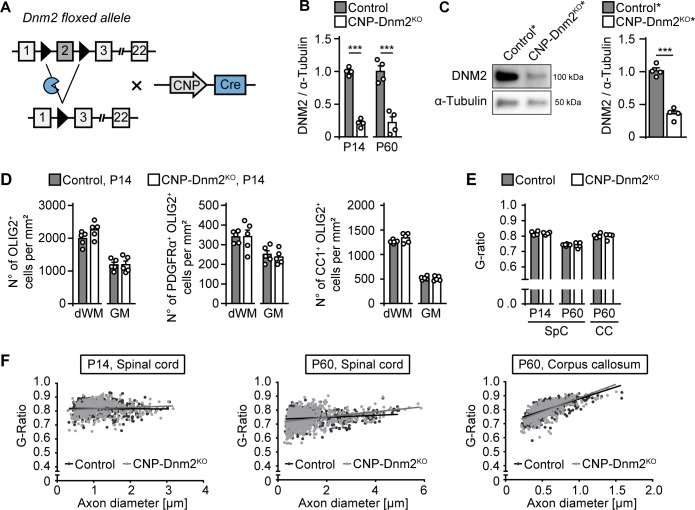
Dynamin 2-depleted oligodendrocytes do not show detectable defects in differentiation and myelination.(A) Schematic representation of Dnm2 ablation in the OL lineage. Exon 2 of Dnm2 is flanked by LoxP sites and excised upon expression of Cre recombinase under the control of CNPase gene regulatory elements. (B) Quantification referring to Figure 5A, full-length blot Supplementary file 1C. Relative amount of DNM2 in spinal cord extracts from Dnm2loxP/loxP (control) and CnpCre:Dnm2loxP/loxP (CNP-Dnm2KO) mice (P14, P60). Control average was set to 1. N = 4 mice/genotype, two-tailed unpaired Student’s t-test. (C) (left panel) Exemplary immunoblot of DNM2 in extracts of primary mouse OLs derived from CnpCre:Rosa26-stoploxP/loxP-YFP (control*) and CnpCre:Dnm2loxP/loxP:Rosa26-stoploxP/loxP-YFP (CNP-Dnm2KO*) from P7 brain (after 14 day in culture). (right panel) Relative amounts of DNM2, full-length blot in Supplementary file 1G. N = 4 mice/genotype, two-tailed unpaired Student’s t-test. (D) Detailed quantification of Figure 5D (spinal cord hemisections). Total OL lineage cells (OLIG2+), OPC (PDGFRα+OLIG2+) and mature OL (CC1+ OLIG2+), in spinal cord dorsal white matter (dWM) and grey matter (GM) of control and CNP-Dnm2KO mice. N = 5 mice/genotype, two-tailed unpaired Student’s t-test. (E) Average g-ratios of control and CNP-Dnm2KO myelinated axons in spinal cord ventral WM (SpC; P14, P60) and CC (P60). At least 108 axons/sample were analyzed (random EM fields). N = 4 or 5 mice/time point and genotype, two-tailed unpaired Student´s t-test. (F) G-ratios as function of axon diameter. Results in graphs represent means ±s.e.m.; ***p<0.001.